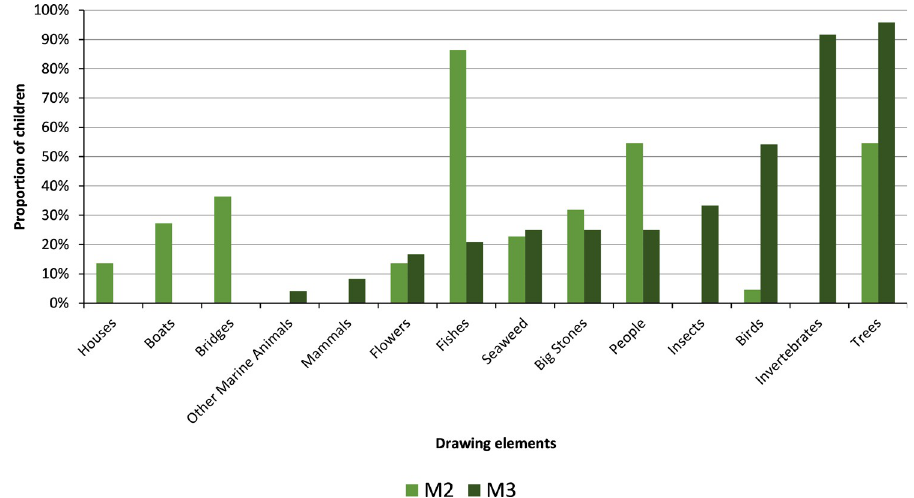
Fig 5. Proportion of students representing different elements related to alterations and biodiversity in their drawings made along with questionnaires of M2 and M3 moments.